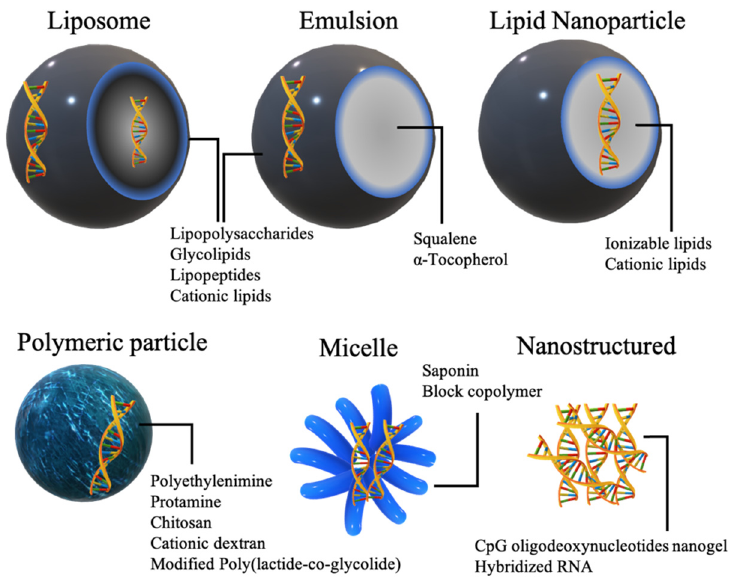
Figure 3. Commonly used nonviral delivery systems for the delivery of adjuvants in nucleic acid vaccines.